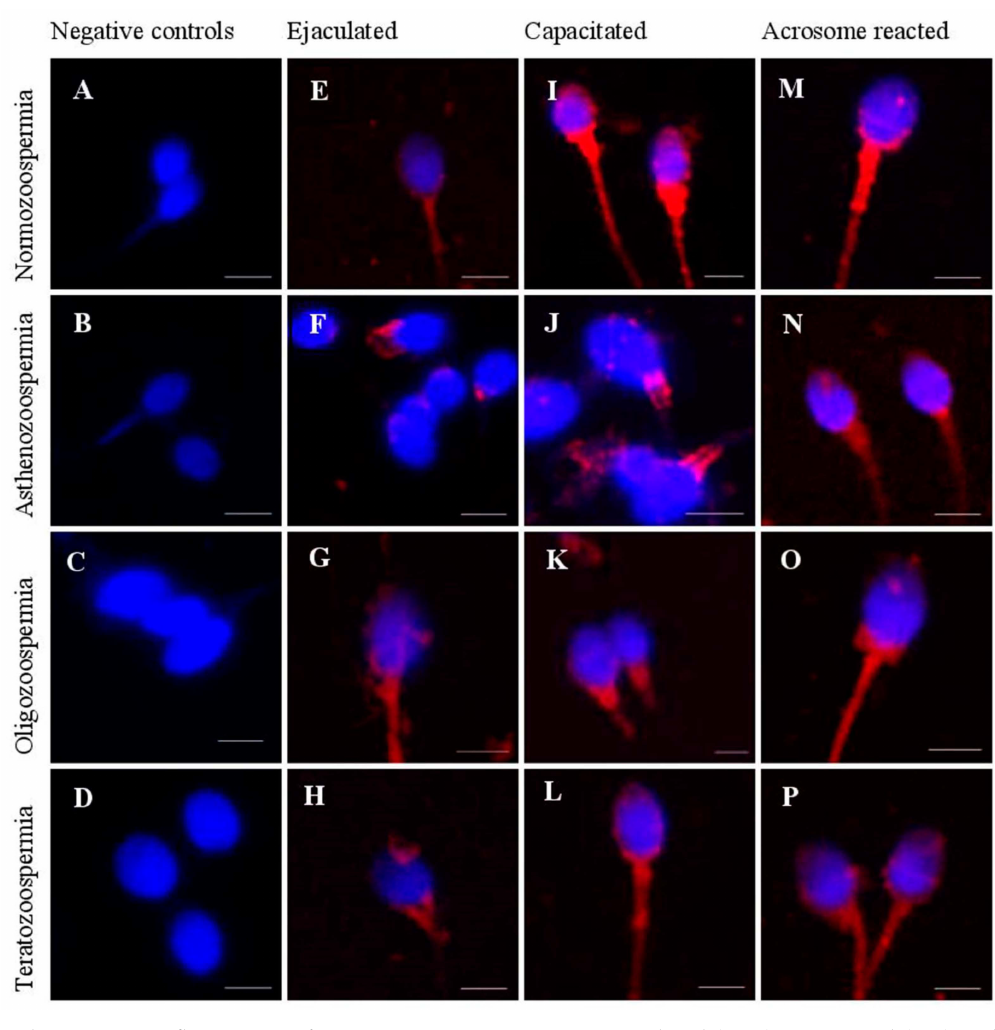
Figure 2. Indirect immunofluorescent of tACE protein expression in ejaculated ( E – H ) capacitated ( I – L ) and acrosome reacted ( M – P ) sperm from different cases of semen pathology (asthenozoospermia, oligozoospermia and teratozoospermia). Note punctate pattern of distribution of tACE in the neck and mid-piece compared to uniform distribution in normospermia. The panel ( A – D ) represents negative controls by omitting of primary antibody in samples from ejaculated spermatozoa from normospermia and from different cases of semen pathology (asthenozoospermia, oligozoospermia and teratozoospermia). Scale bar = 5 µ m.